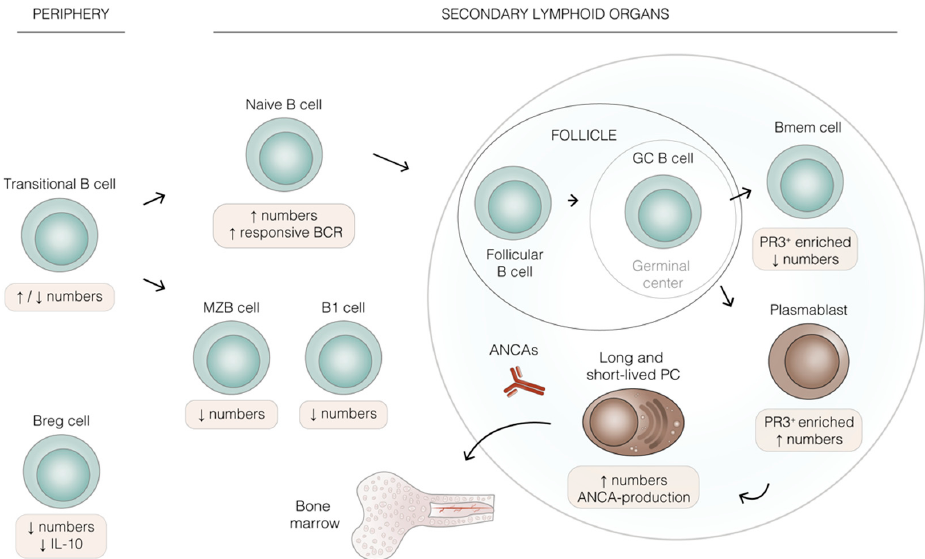
Figure 1. B cell lineage development and altered B cell populations in ANCA-associated vasculitis (AAV). Schematic representation of human B lineage cell differentiation. Beige boxes highlight the effects of AAV on the indicated cell populations. The extra-follicular pathway of B cell differentiation is not shown for simplicity. Transitional B cells migrate into secondary lymphoid organs, where they differentiate into innate-like B1, marginal zone B (MZB) cells, or naive B cells. Naive B cells enter lymph nodes and become follicular B cells, and it is within the follicle that a T-cell dependent response triggers the formation of germinal centers (GCs). During the GC reaction, the GC B cell may generate memory B cells (Bmem), plasmablasts, or plasma cells (PCs), which reduce the pathogenic anti-neutrophil cytoplasmic antibodies (ANCAs). PCs may be short- or long-lived and home to the bone marrow, whereas Bmem egress into the periphery. B regulatory cells (Breg) may arise from almost all B cell lineage populations. All the aforementioned B cell populations have been found to be dysregulated in AAV, being increased or decreased, as shown by the arrows in the beige boxes. Abbreviations: PR3 (proteinase 3), BCR (B cell receptor).